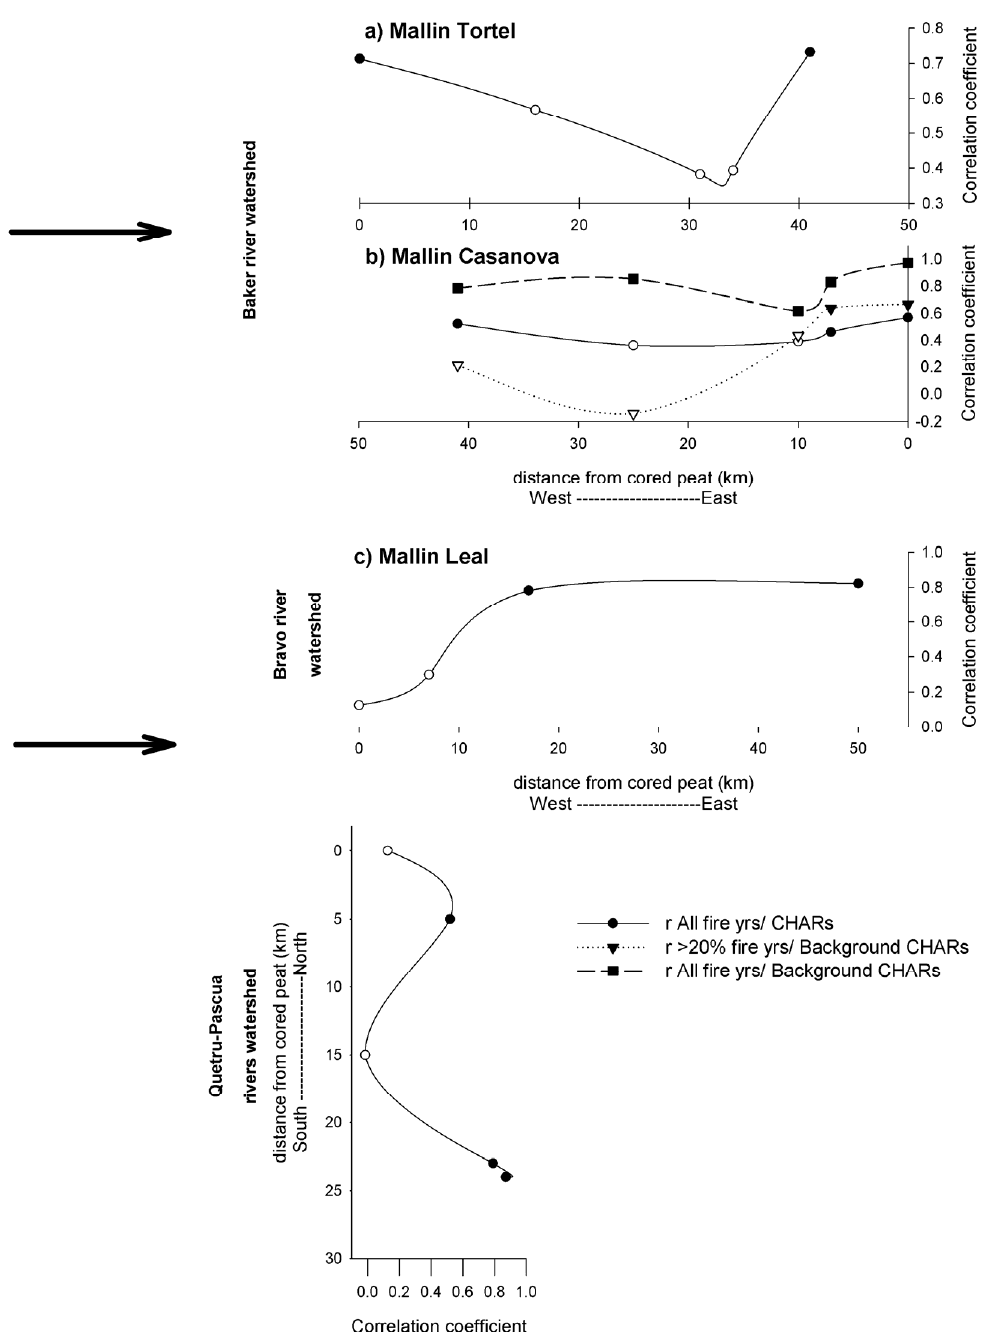
Fig. 6. Spatial variation of correlation coefficients between individual fire scar records (smoothed) and the (a) mall´ın Tortel, (b) mall´ın Casanova, and (c) mall´ın Leal charcoal records. Circle, square and inversed triangle based scatterplots represent correlations between records of smoothed all fire years and CHARs, smoothed all fire years and Background CHARs, and smoothed widespread fire years and Background CHARs, respectively. Background CHAR records were found only in the mall ´ ın Casanova. Significant Spearman correlations ( P < 0.05) between records are shown in solid symbols (i.e. black circles and inversed triangles), and all squares are significantly correlated. The horizontal and vertical displays of the panels represent the west-east and north-south gradients from each coring site, respectively. The black horizontal arrow represents the direction of the prevailing southern westerly winds (SWW) in relation to the sampled sites. The periods used for the smoothing of the fire scar records are in Table S1 in the